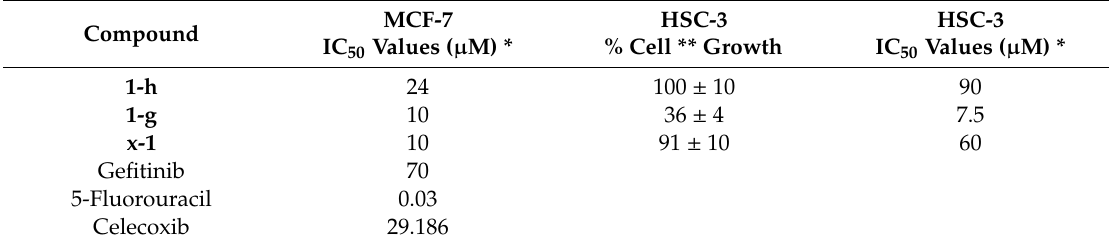
Table 8. IC 50 values of the new synthesized compounds as well as gefitinib, 5-fluorouracil and celecoxib.